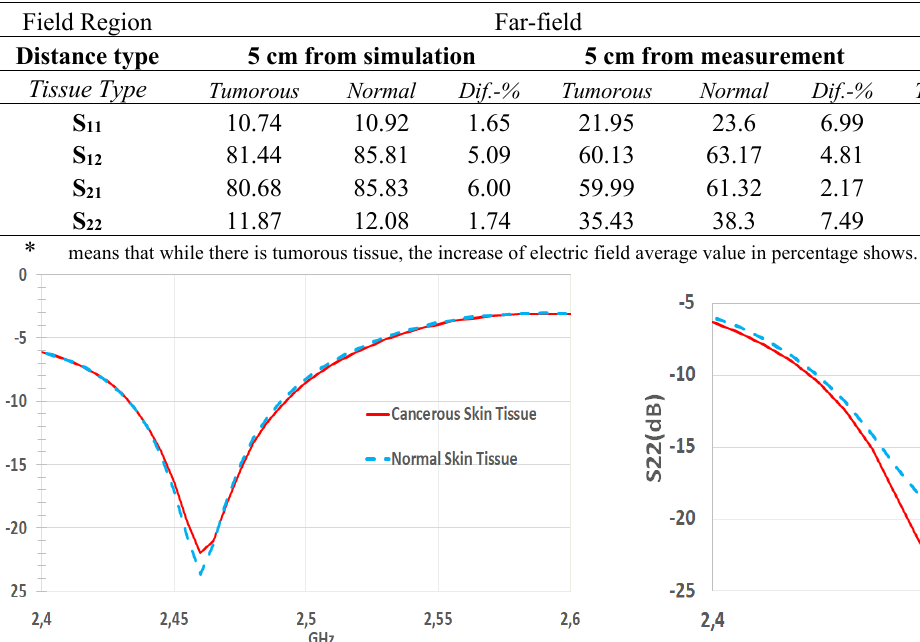
Table 1. Maximum Values of S-Parameters' Absolutes